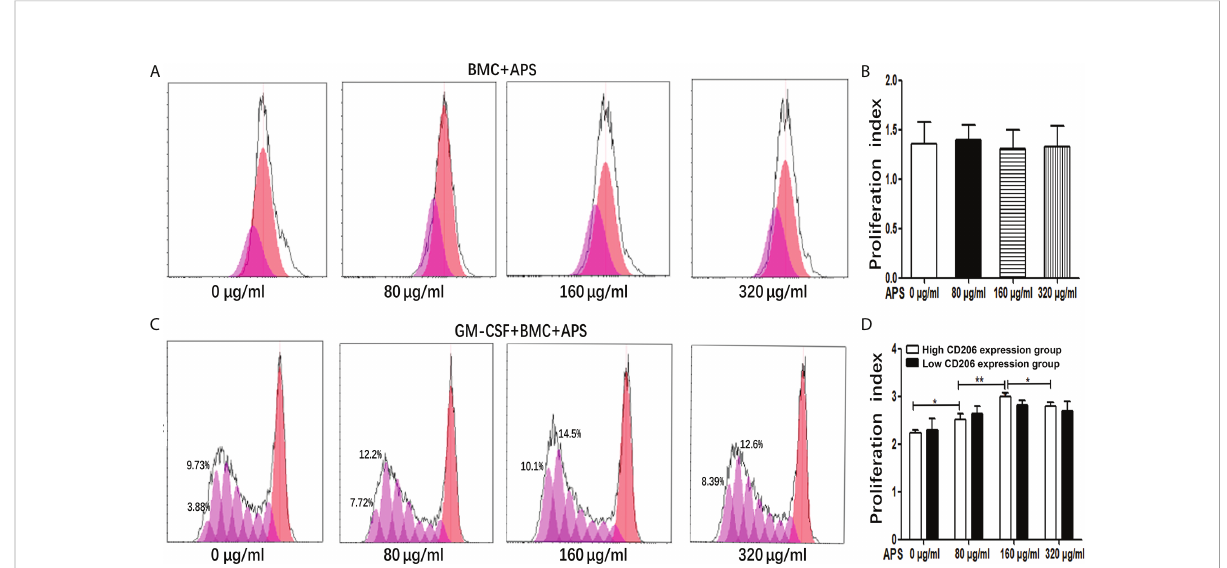
FIGURE 1 The effect of APS on MDSC proliferation. (A) BMC which were isolated from normal mouse were treated with APS (0, 80, 160 and 320 m g/ml) for 72 h. One representative result from each experiment is shown. (B) Proliferation index of BMC which were isolated from normal mouse treated with APS. (C) BMC which were isolated from normal mouse were treated with GM-CSF and APS (0, 80, 160 and 320 m g/ml) for 72 h. One representative result from each experiment is shown. (D) Proliferation index of MDSC (**p<0.01, *p<0.05). n=5, Data are expressed by mean ±